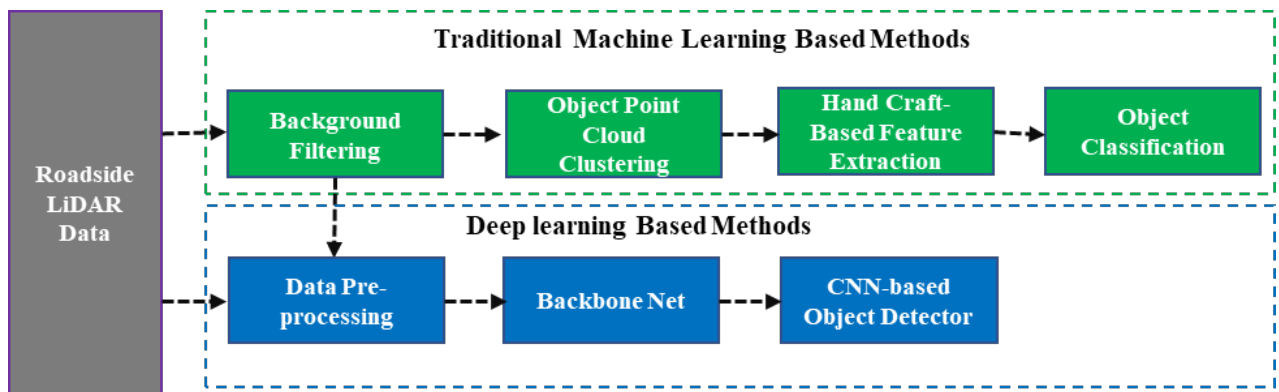
Figure 3. Technical route based on a single roadside LiDAR.